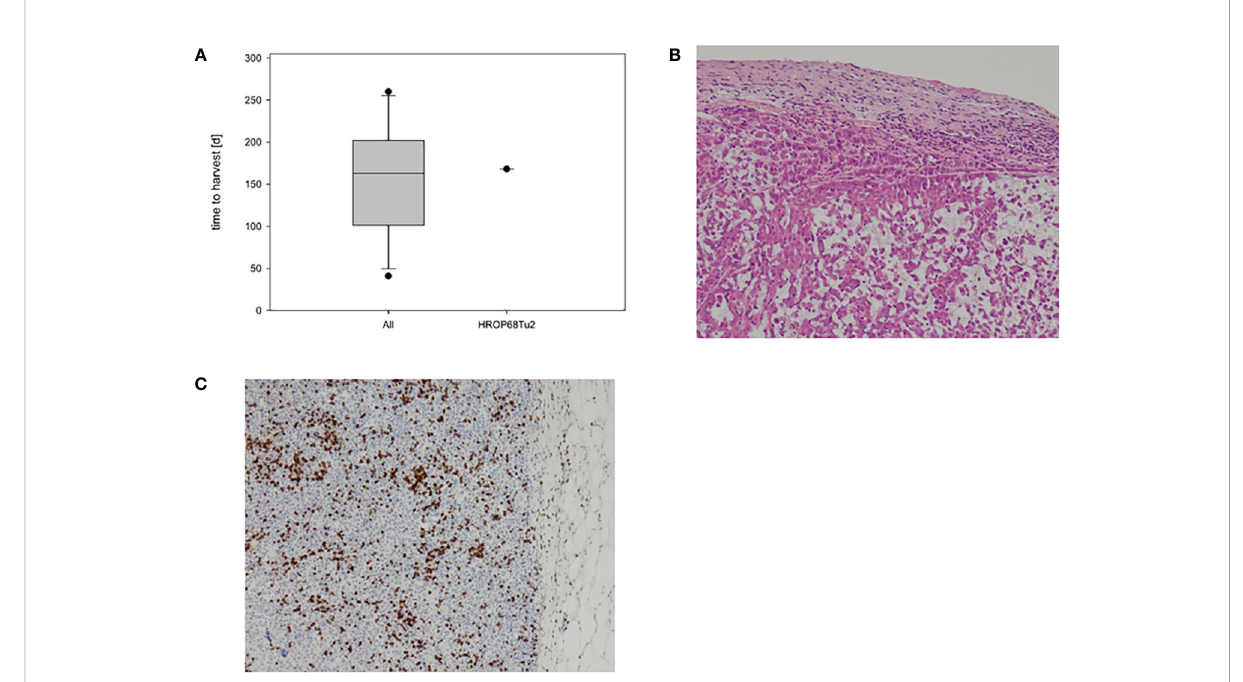
FIGURE 3 HROP68Tu2 PDX. Growth kinetics of HROP68Tu2 (A) compared to other pancreatic PDXs with successful outgrowth in passage fT0 (n = 12). The in vivo growth of HROP68Tu2 did not differ from the median growth rate of other pancreatic PDX. The hematoxylin – eosin stain of the PDX (B; 20x) revealed a close resemblance to the original donor tumor (B) . Tumor cells showed strong immunostaining for PD-L1 (C) .